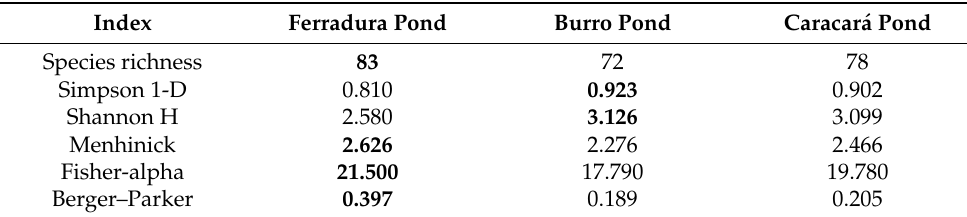
Table 2. Mean values ( ± standard deviation) of diversity indexes (see methods) for the sampling sites in each of the three ponds studied. ANOVA tests show differences among ponds. The indexes for each pond are also shown considering all sampling sites in each pond